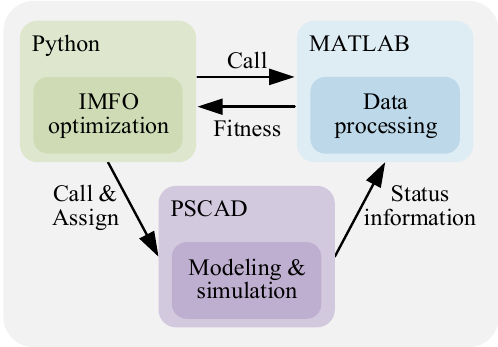
Figure 7. Joint Simulation Structure